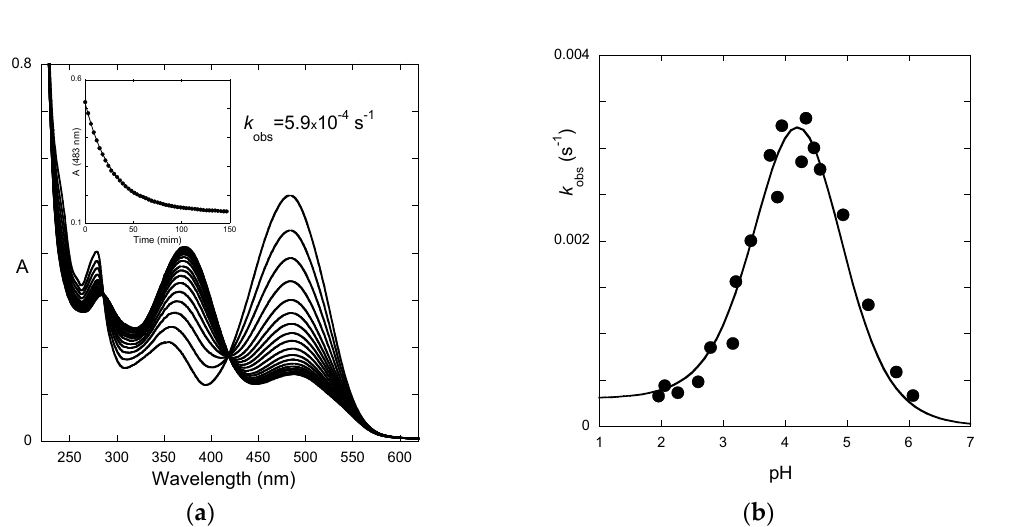
Figure 9. ( a ) time-dependence of the UV-visible spectrum of P5 after a direct pH jump from 1 to 5.8; and ( b ) pH-dependence of the apparent first-order rate constant of flavylium consumption and its fitting according to Equation (14): K h K t k i = 8.5 × 10 − 7 M·s − 1 ; k − i = 3.0 × 10 − 4 s − 1 ; k i k t / k − h = 1.6 × 10 − 5 M s − 1